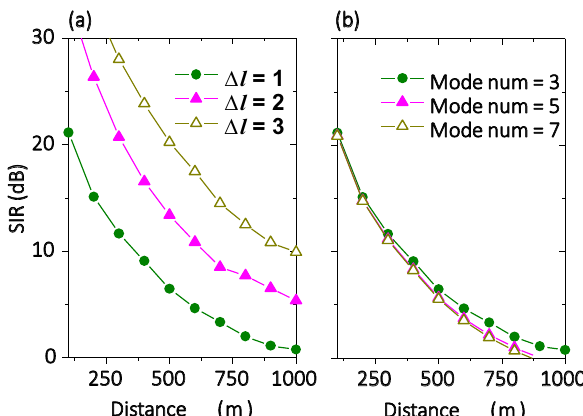
Figure 7. Signal-to-Interference ratio performance for multiple multiplexed OAM beams. Systems with ( a ) 3-muxed OAM modes with mode spacing from 1 to 3 (OAM beams of [+ 3, + 4, + 5]; [+ 2, + 4, + 6]; and [+ 1, + 4, + 7] are transmitted, respectively), and ( b ) 3-to-7-muxed OAM modes with a mode spacing of 1 (OAM beams of [+ 3, + 4, + 5]; [+ 2, + 3, + 4, + 5, + 6]; and [+ 1, + 2, + 3, + 4, + 5, + 6, + 7] are transmitted, respectively). The 2 parameters are set as C n = 1 × 10 –11 m -2/3 , w 0 = 0.1 m and f = 0.5 THz. Scales in y -axis in ( a , b ) are the same.